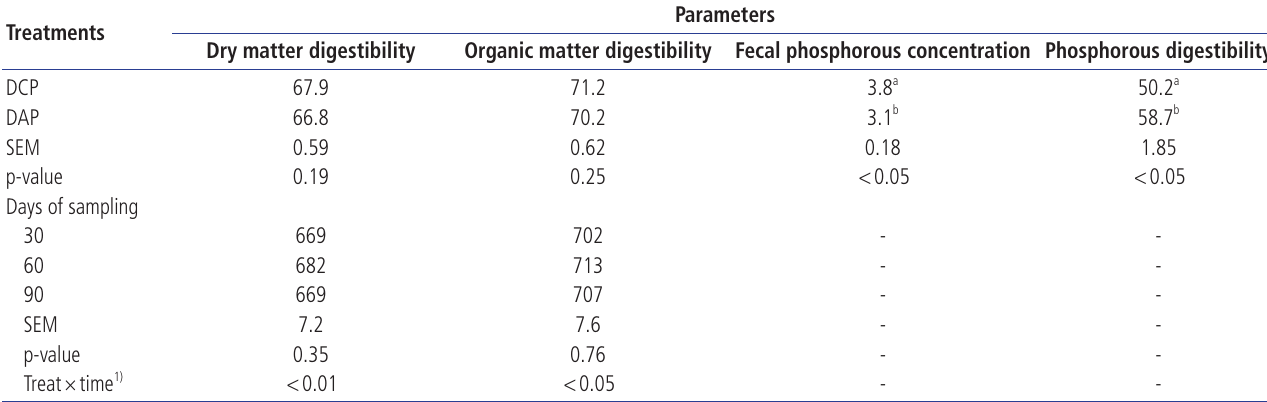
Table 4. Dry mater, organic matter and phosphorous apparent total tract digestibility (%) and fecal phosphorous concentration (g/kg DM) of finishing lambs fed a diet supplemented with either di-calcium phosphate (DCP) or di-ammonium phosphate (DAP) as the phosphorous source